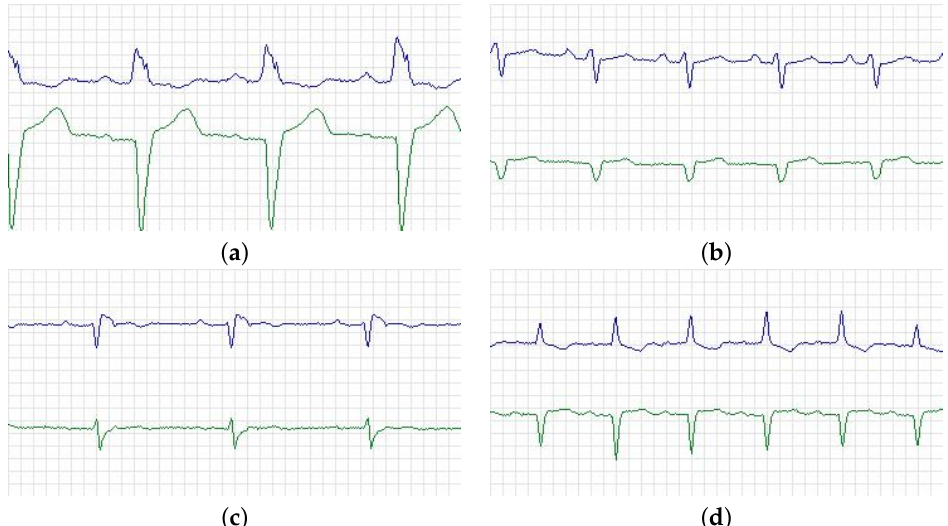
Figure 3. Partial waveform of BIDMC database. ( a ) is from a 71-year-old male and belong to class N in AAMI standard; ( b ) is from a 61-year-old female and belong to class S in AAMI standard; ( c ) is from a 51-year-old male and belong to class S in AAMI standard; ( d ) is from a 22-year-old male and belong to class S in AAMI